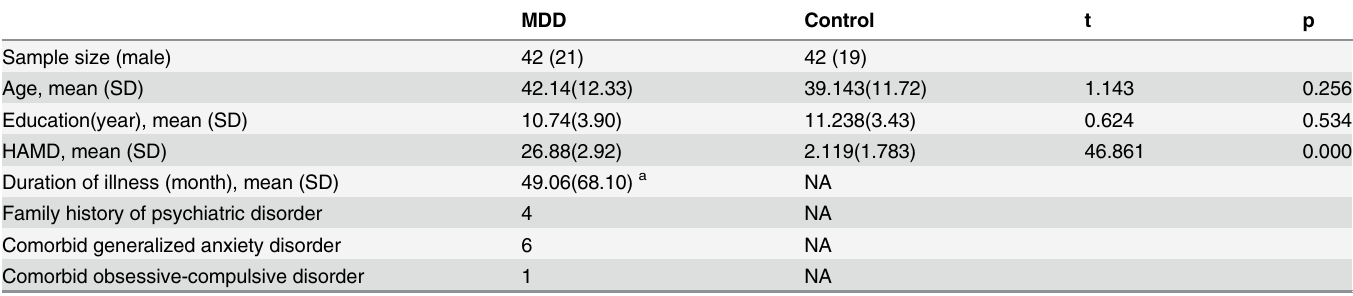
Table 1. Demographic and clinical characteristics of the study